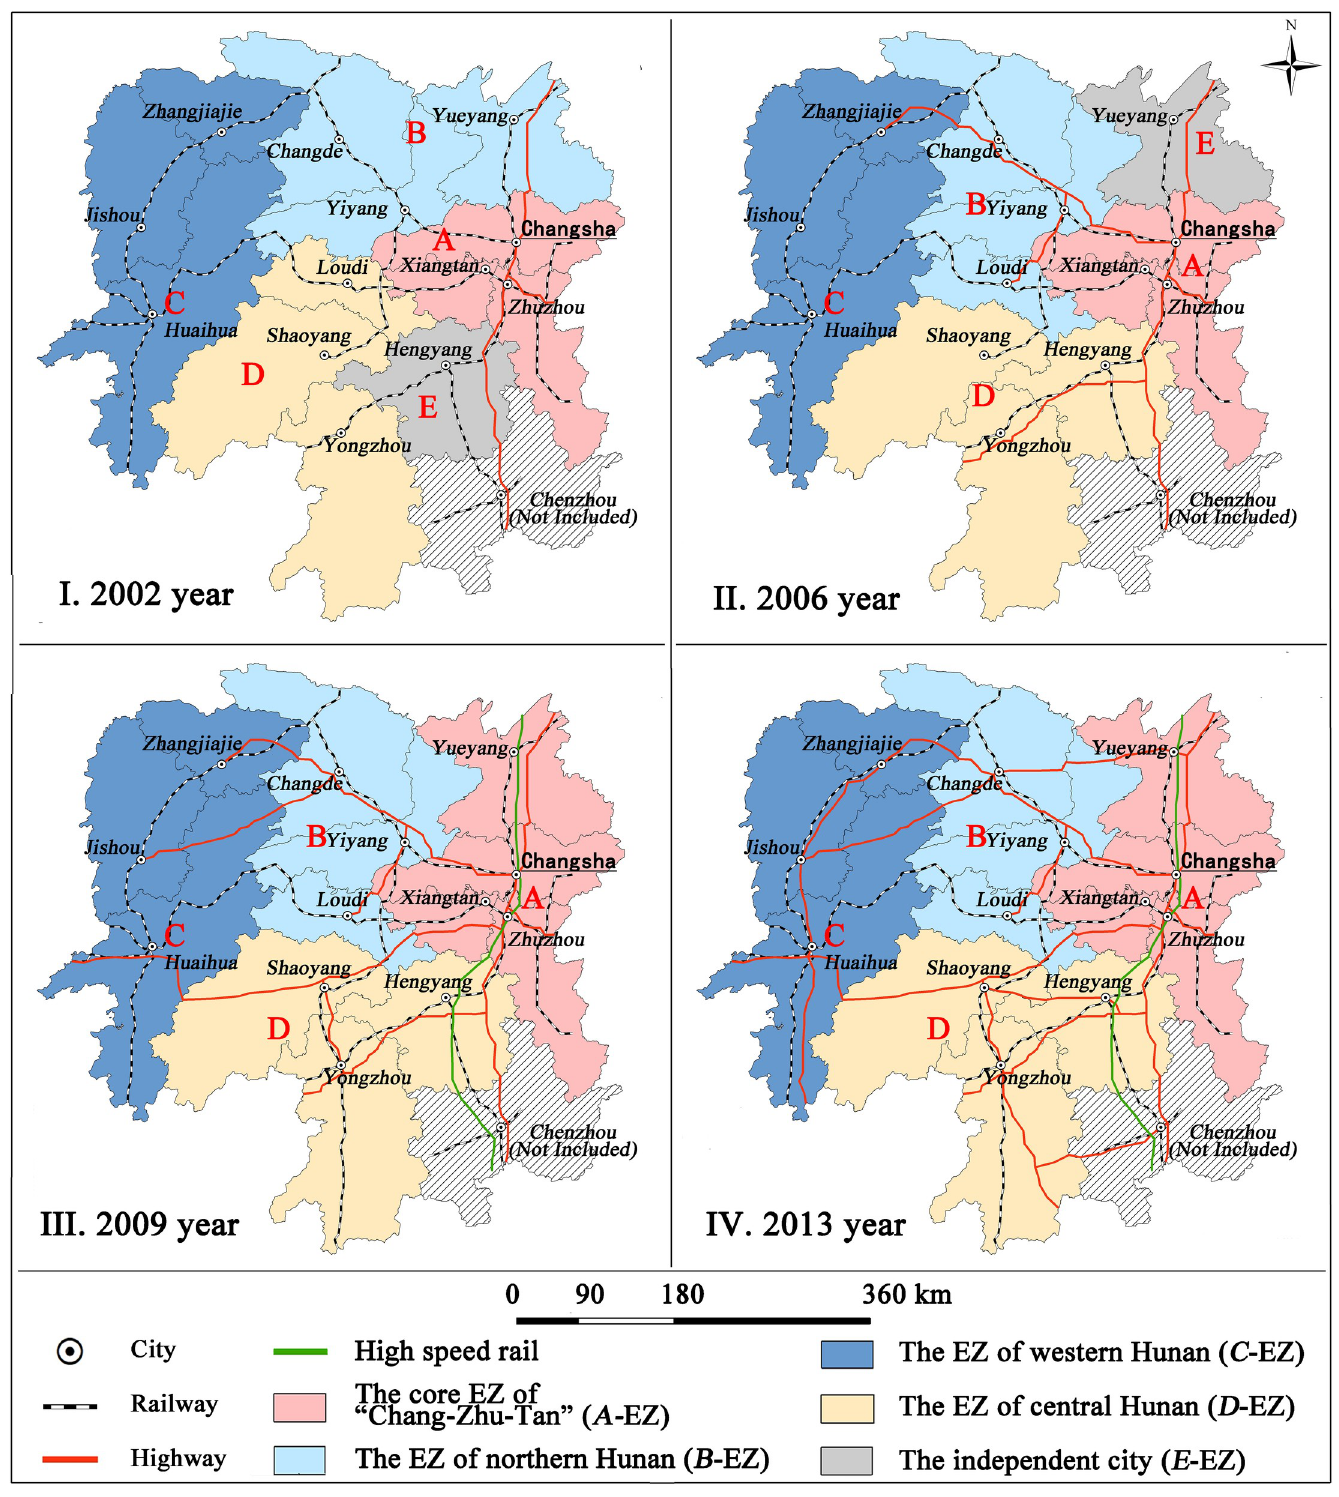
Fig 3. Temporal changes of the new proposed DEZ of Hunan Province from 2002 to 2013. (Reprinted from http://www.ngcc.cn/ngcc/ under a CC BY license, with permission from the National Geomatics Center of China , original copyright 2012).